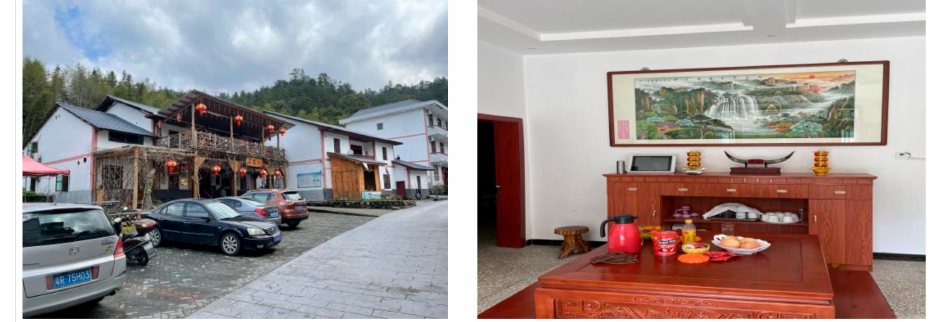
Figure 5. Photo of farmer